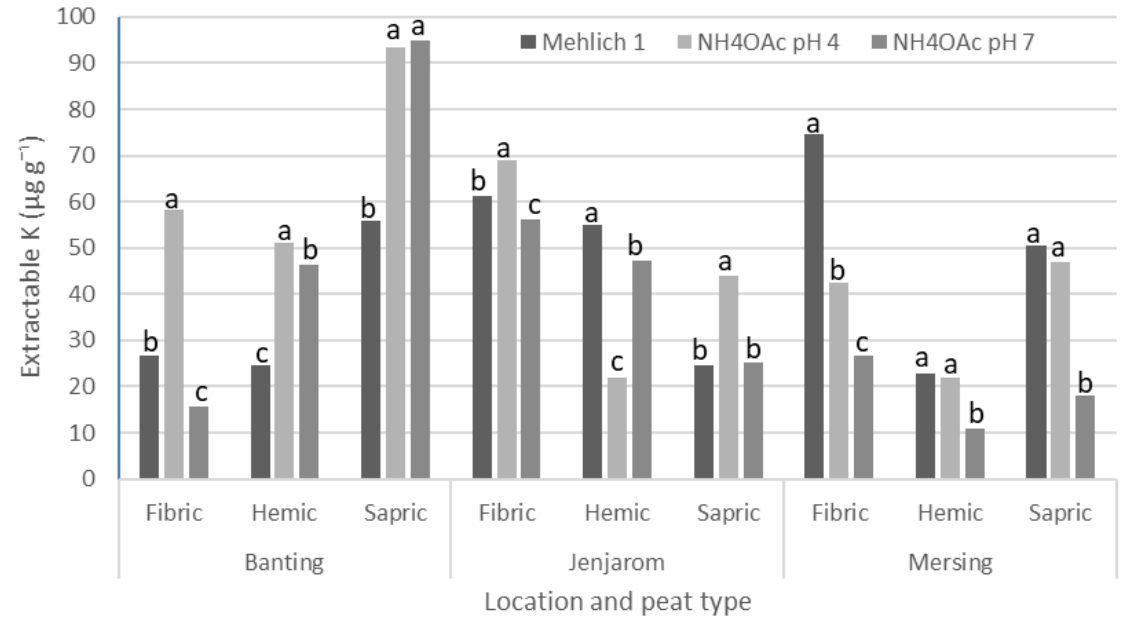
Figure 1. Comparison of the amounts of K + obtained, using three different extractants, from Fibric, Hemic and Sapric peat collected at three different locations (Banting, Jenjarom, Mersing) in peninsular Malaysia. Different letters (per peat type and location) indicate significant differences between means (Tukey’s test at P =